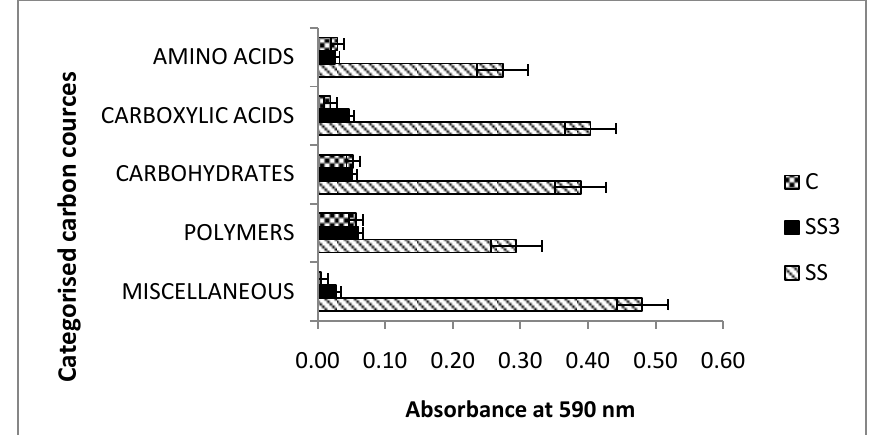
Figure 6. Categorized substrate utilization patterns by the microbial communities from the soil after 48 h of incubation. Errors bars indicate the standard errors of the mean ( n = 3).